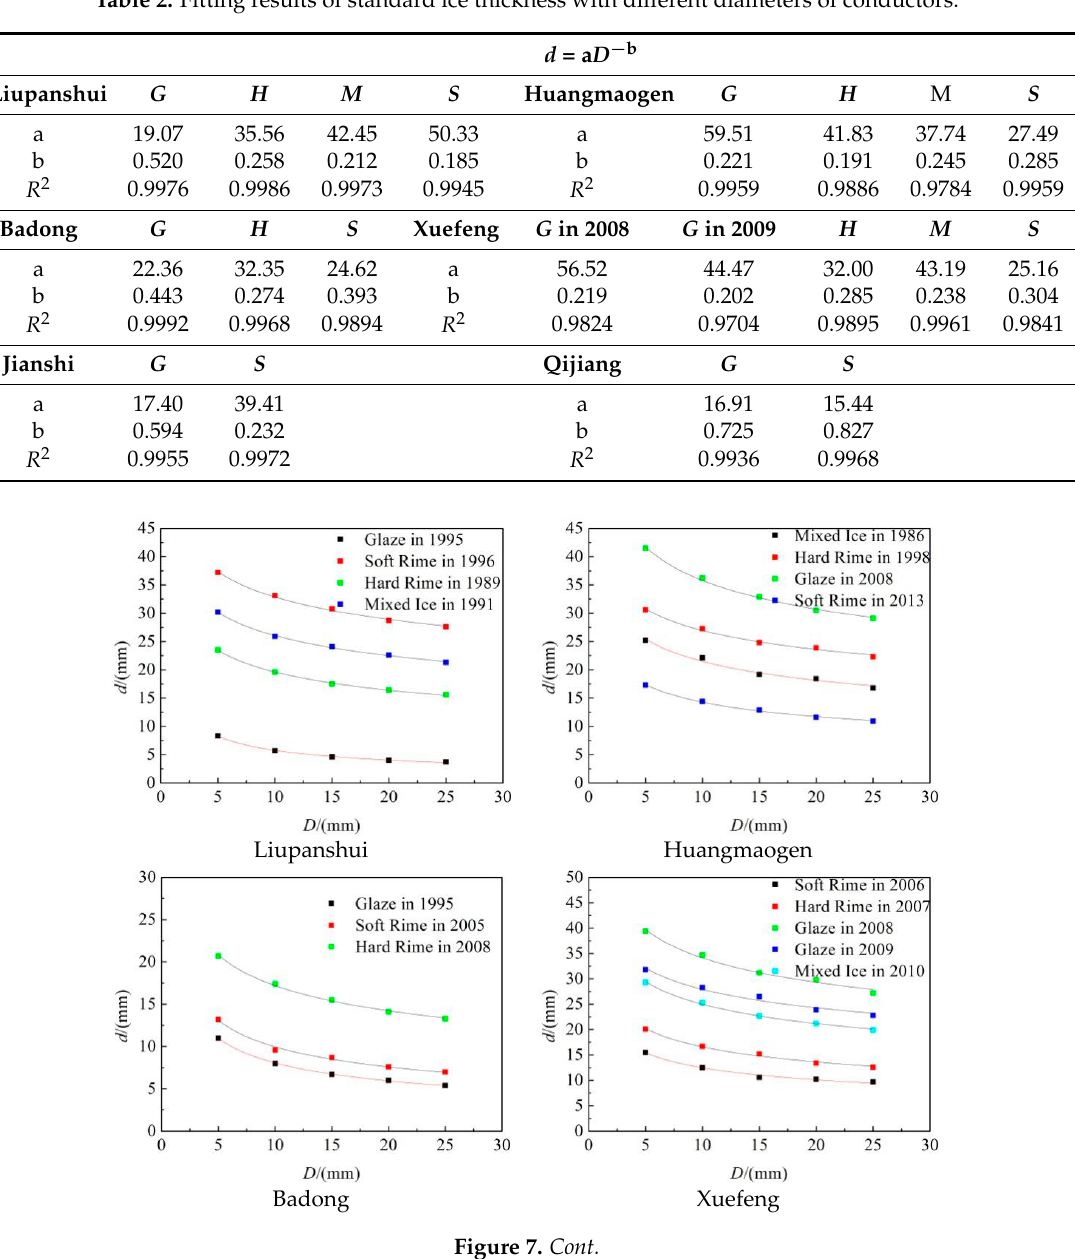
Table 2. Fitting results of standard ice thickness with different diameters of conductors.